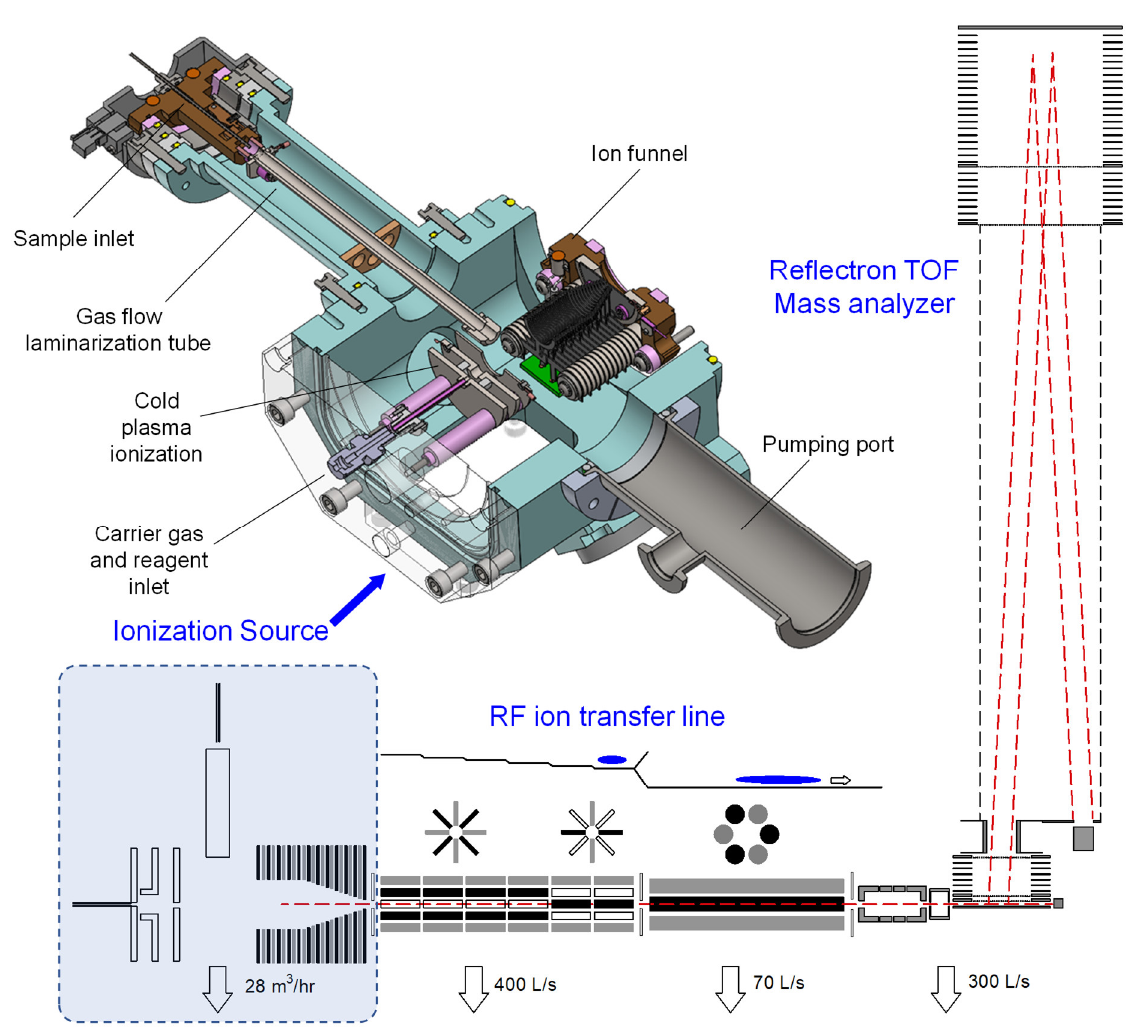
Figure 1. Schematic diagram highlighting the main components of the TOF MS and cross-sectional view of the design of the ionization source.